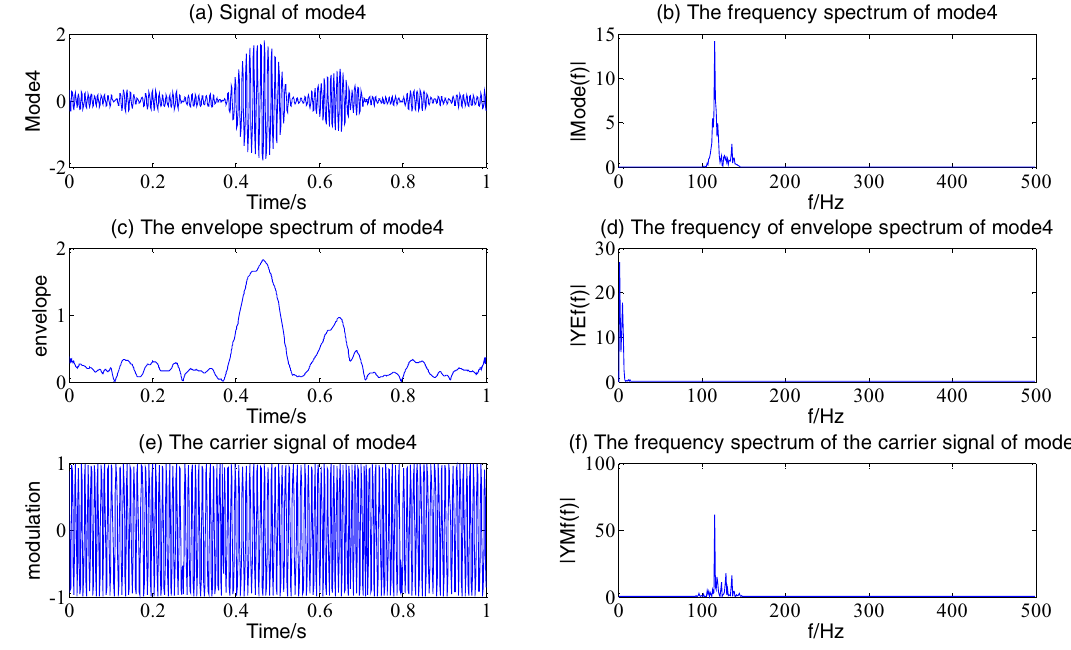
Figure 6. The envelope demodulation distribution diagram of mode4.